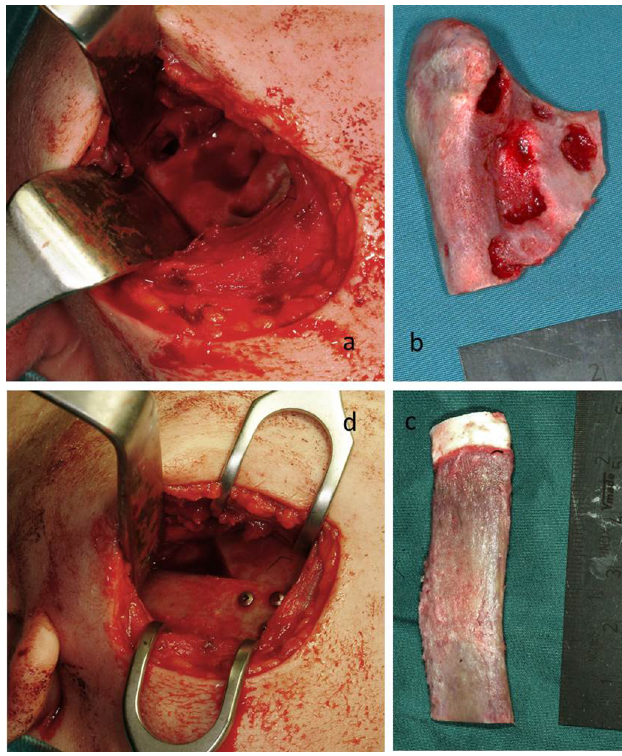
Fig. 2. Intraoperative view of the right condyle (a) with round osteolyses caused by the solitary bony cyst (b). After resection a costochondral rip graft was transplanted (c) and fi xed on the remaining mandibular jaw (d).